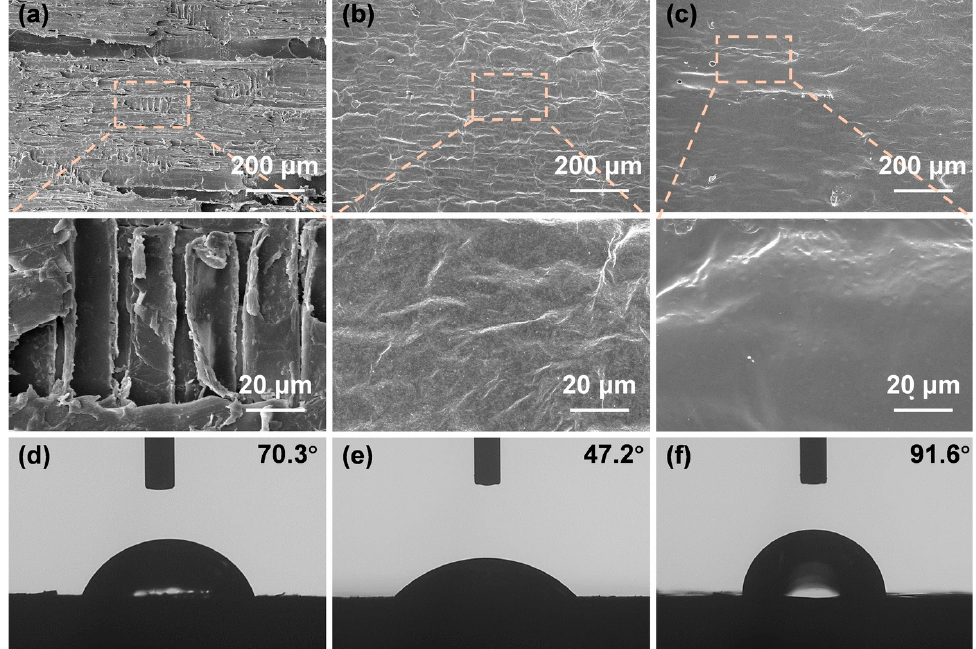
Figure 16. SEM images of ( a ) the untreated wood, ( b ) MXene-coated wood, and ( c ) waterborne acrylic resin (WA) on MXene-coated wood. Water contact angle after 1 s of ( d ) natural wood, ( e ) MXene-coated wood, and ( f ) waterborne acrylic resin (WA) on MXene-coated wood [73].